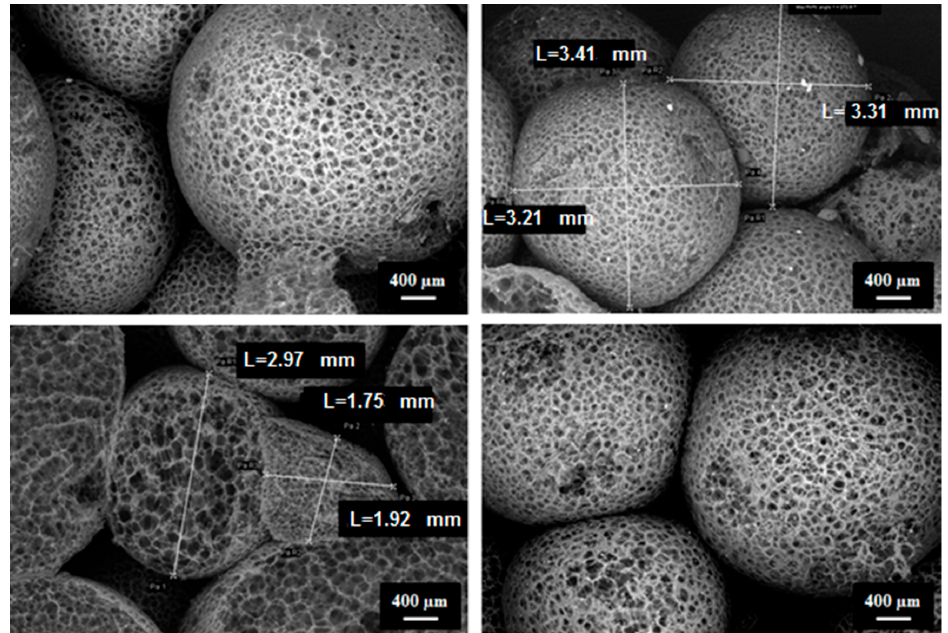
Figure 9. SEM images of EPS samples carried out at Saint-Gobain Research Paris.